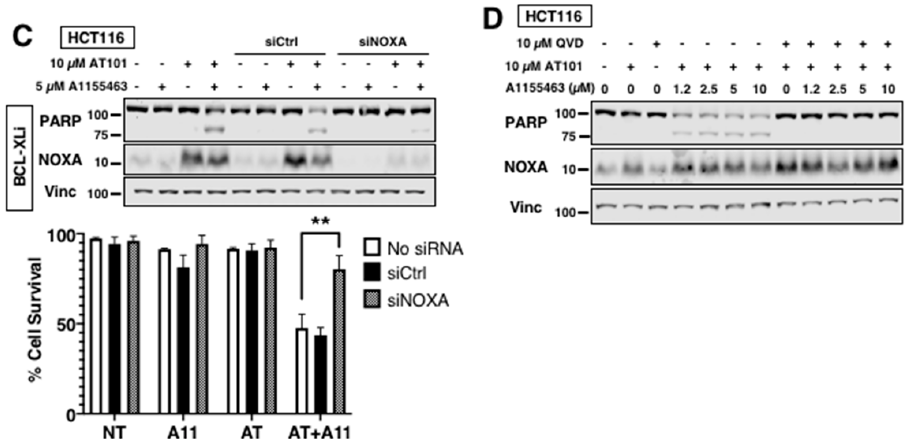
Figure 3. AT101 sensitizes carcinoma cells to other BH3 mimetics. ( A ) HCT116 cells and ( B ) MiaPaca2 cells were incubated with either ABT-263, ABT-199 or A1155463 alone or in combination with 10 µ M AT101 for 6 h. ( C ) HCT116 cells were transfected with non-targeting siRNA (siCtrl) or siRNA against NOXA (siNOXA) then incubated with either 5 µ M A1155463, 10 µ M AT101 or both for 6 h. Apoptosis was assessed by PARP cleavage and chromatin condensation, expressed as the percentage of surviving cells ( n = 3, error bars represent standard deviation, ** p < 0.01). ( D ) HCT116 cells were incubated with 10 μ M QVD for 1 h and then with A1155463 alone or in combination with 10 μ M AT101 for 6 h.